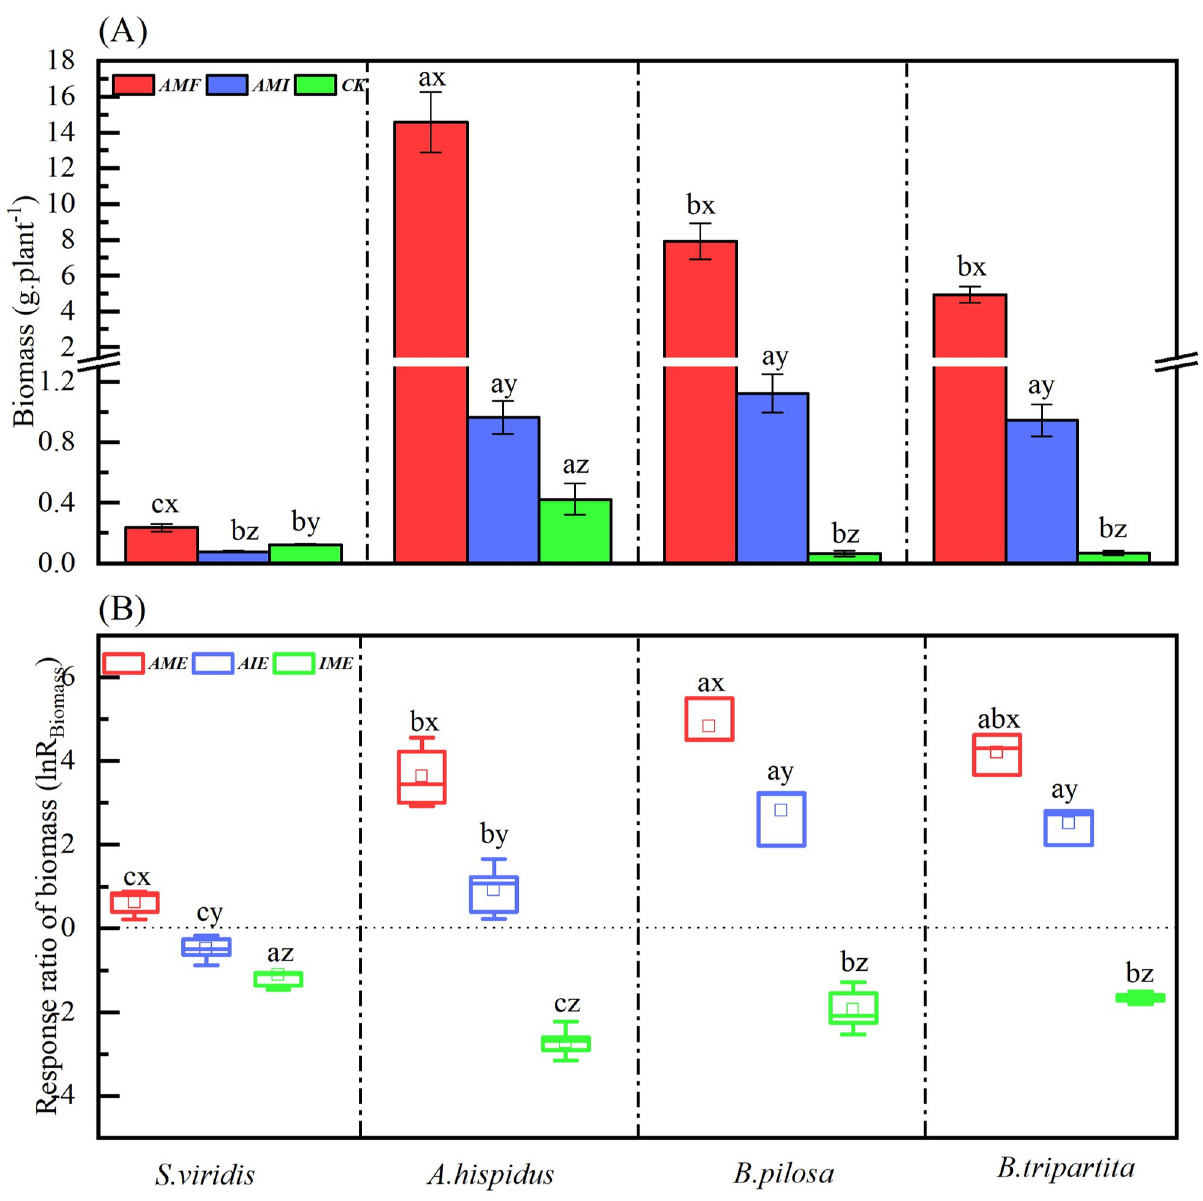
Fig 1. The biomass (A) and its response ratio lnR (B) of four plant species through the different microbial treatments. Abbreviations: S . v = Biomass Setaria viridis ; A . h = Arthraxon hispidus ; B . p = Bidens pilosa ; B . t = Bidens tripartita ; AMF = the mycorrhizal fungi soil by AM fungi inoculation; AMI = the combining soil by AM fungi with indigenous microorganism; CK = the sterilized soil as the control by removing microorganism; AME = AM fungi effect; AIE = interactive effect related to AM fungi interacting with indigenous microbes; I ME = indigenous microbial effect related to AM fungi. The different lowercase letters (a, b, c, d) indicate significant differences between species under AMF , AMI , and CK treatments, respectively. The different lowercase letters (x, y, z) indicate significant differences between AMF , AMI , and CK treatments for the same species ( P < 0.05).